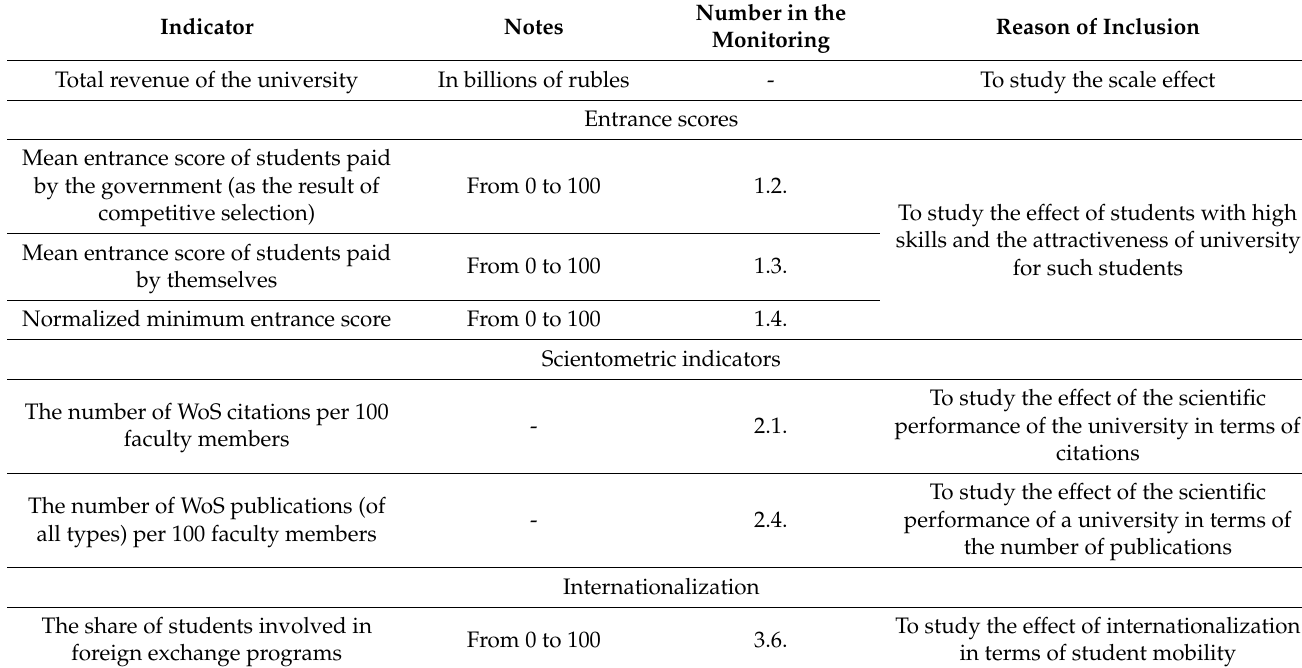
Table 2. Explanatory variables in the